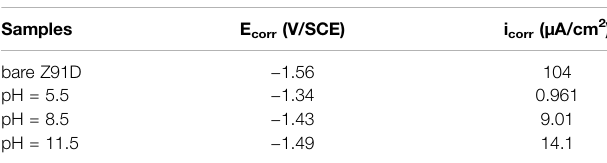
TABLE 2 | Fitted results of polarization curves in Figure 6A .